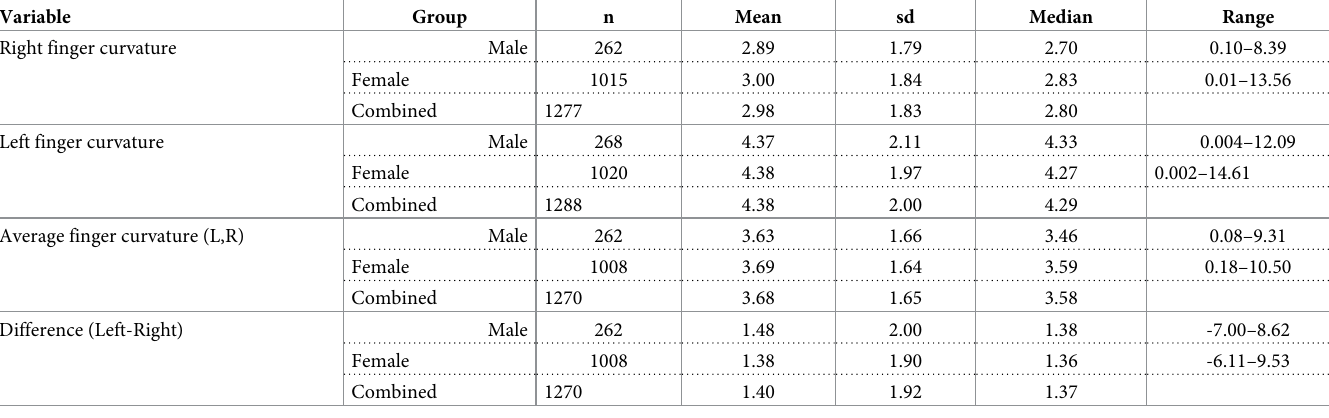
Table 1. Descriptive statistics for fifth finger